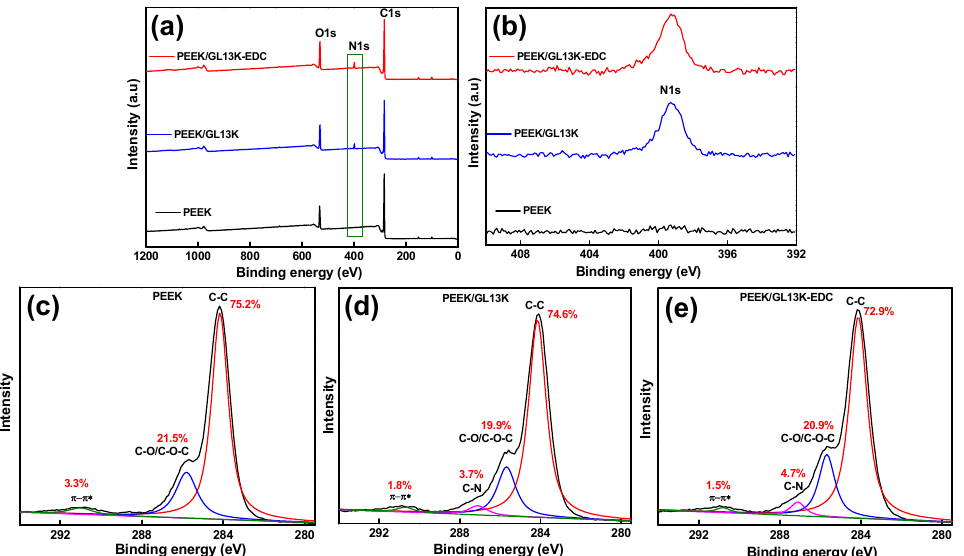
Figure 4. X-ray photoelectron spectroscopy (XPS) spectra of ( a ) full scans, ( b ) detailed scans of N1s, and ( c – e ) detailed scans of C 1s in PEEK, PEEK/GL13K, and PEEK/GL13K-EDC samples.